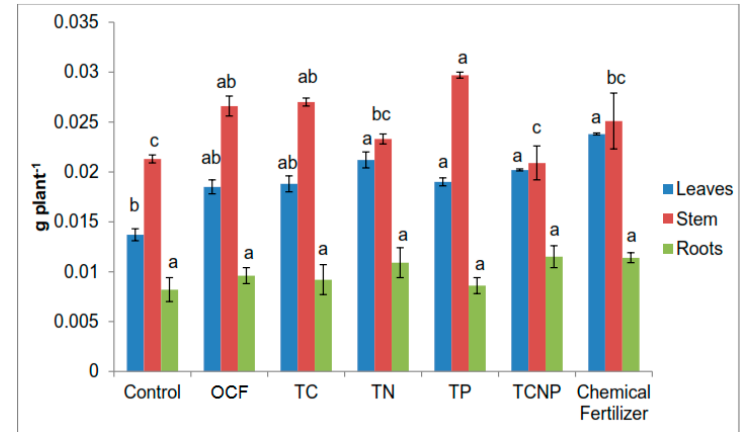
Figure 4. Effect of treatments on phosphorus uptake in maize plants. Different letters for similar colored bars indicate significant difference between treatment means using Tukey’s test at P ≤ 0.05. Phosphorus uptake was calculated by multiplying phosphorus concentration and the dry weight of the respective plant parts.